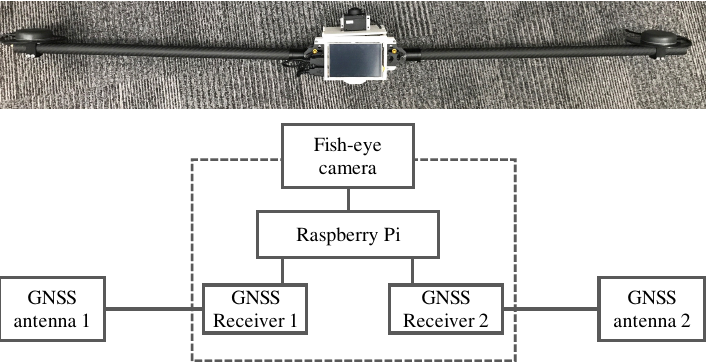
Figure 7. We developed an automatic NLOS training data acquisition device. We used a fish-eye camera and two GNSS antennas/receivers to determine the NLOS satellite for SVM and NN training.